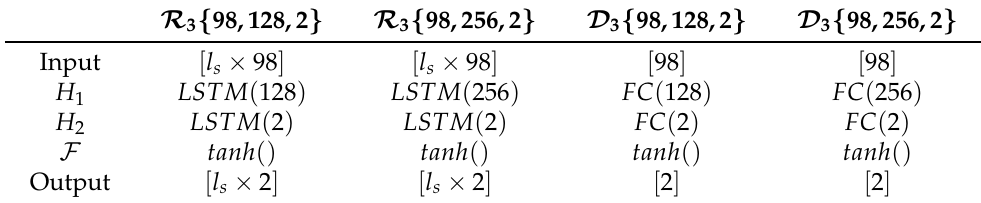
Table 1. The RNN ( R ) and DNN ( D ) architectures used.